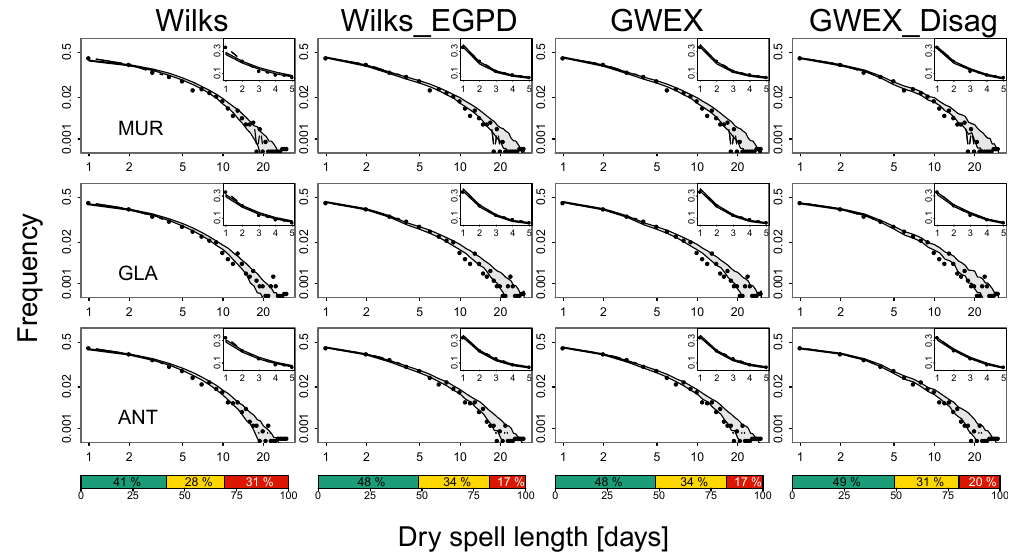
Figure 8. Distribution of dry spell lengths at the stations: the 90% probability limits are shown. Overall performance is represented by the indicated percentages of good, fair, and poor performance for all sites. Inset plots provide a zoom for durations of 1 to 5 days.